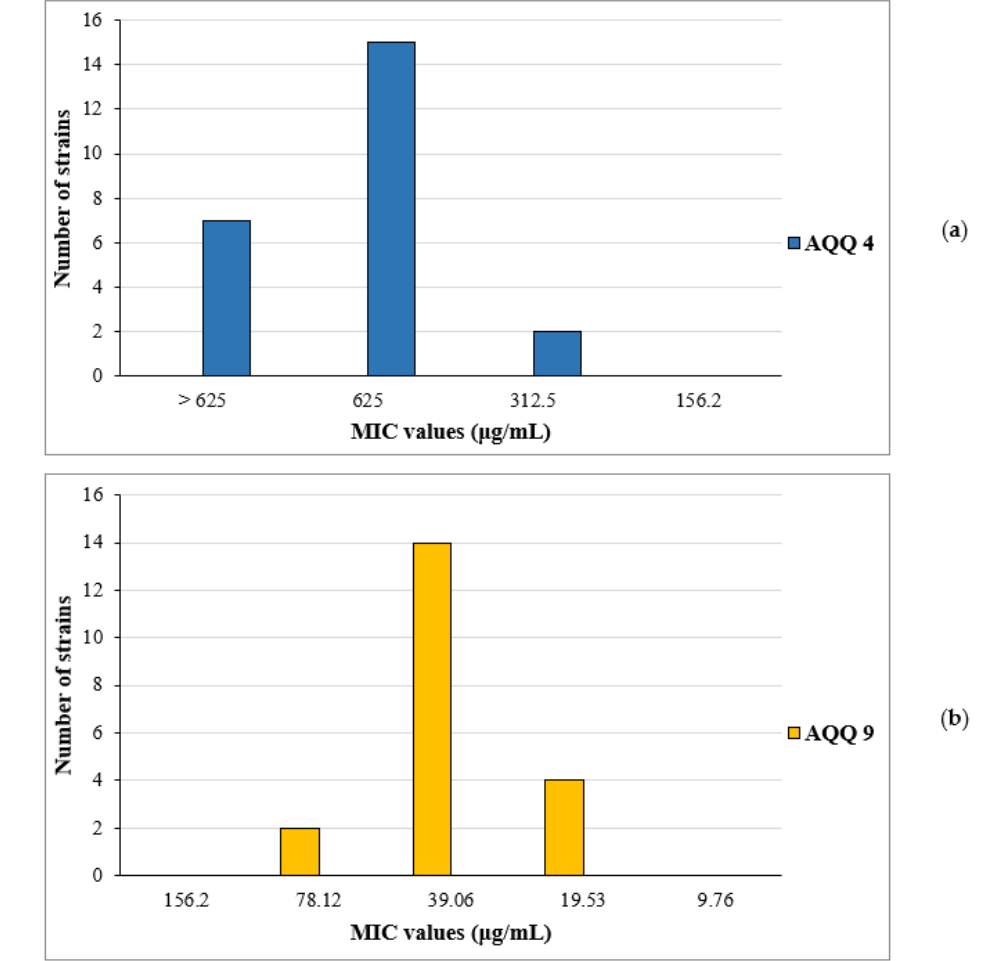
Figure 5. MIC distribution of AQQ4 and AQQ9 ; ( a ) the MIC distribution of AQQ4 against 24 clini- cally obtained C. albicans and non-albicans strains, ( b ) the MIC distribution of AQQ9 against 20 clin- ically obtained MRSA isolates.